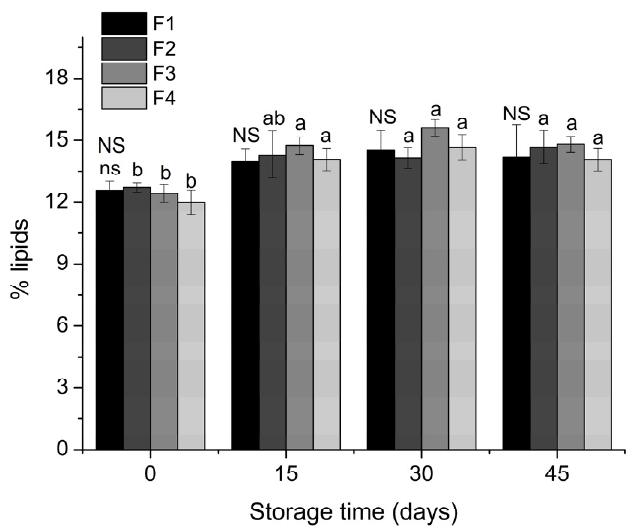
Figure 3. % Total lipids for the four starch biscuit formulations during storage time. F1: starch biscuit control (no added antioxidant); F2: starch biscuit added butylated hydroxytoluene (BHT); F3: starch biscuit added microencapsulated propolis co-product (MECP); F4: starch biscuit added lyophilized propolis co-product (LFCP). NS: there are no statistical differences ( p > 0.05) by the Tukey test between the formulations in the respective storage time. Different lower-case letters above the formulation column represent statistical differences ( p < 0.05) by the Tukey test for the formulation over the storage time.